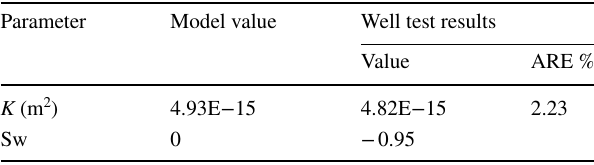
Fig. 11 Log–log pressure and derivative (pressure vs two-phase pseudo-pressure in BU2 test case 1) Table 3 Results of BU2 test using normalized two-phase pseudo-